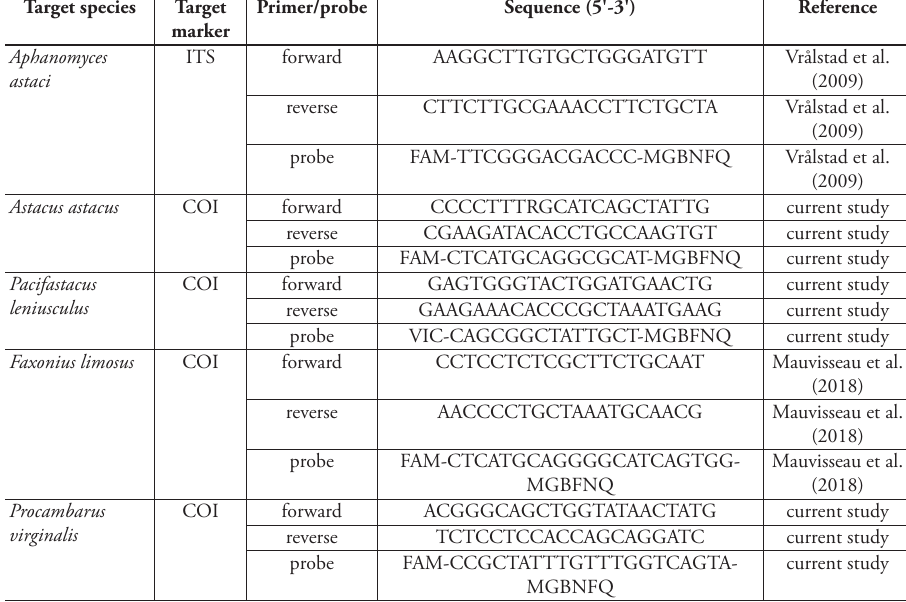
table 1. Primers and probes used in the present study. The probes used are TaqMan MGB probes with either FAM or VIC reporter